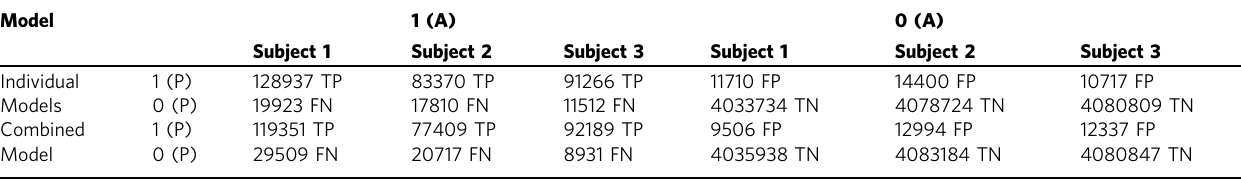
Table 1 Pixelwise validation.